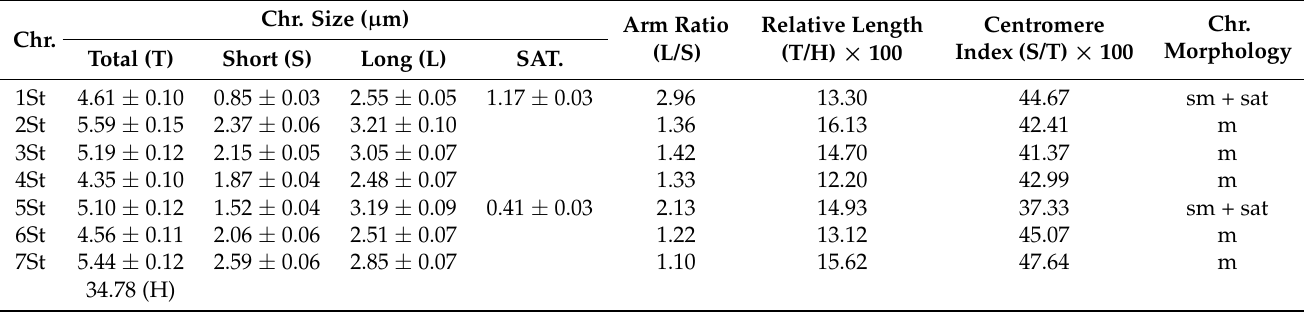
Table 2. Karyotype information in P. libanotica .